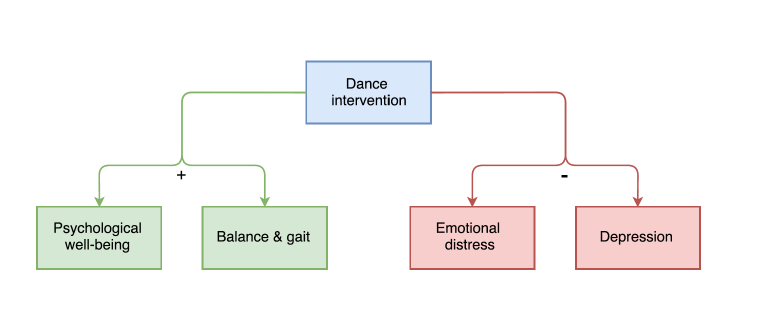
Fig. 1 Bayesian network of the dance intervention